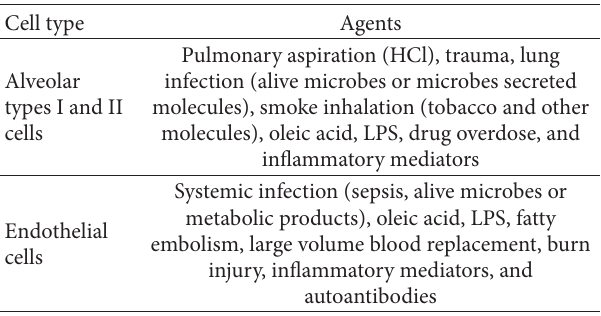
Table 1: Major agents that cause pulmonary